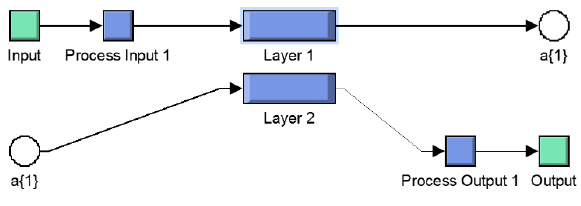
Inventions 2020 , 5 , x FOR PEER REVIEW